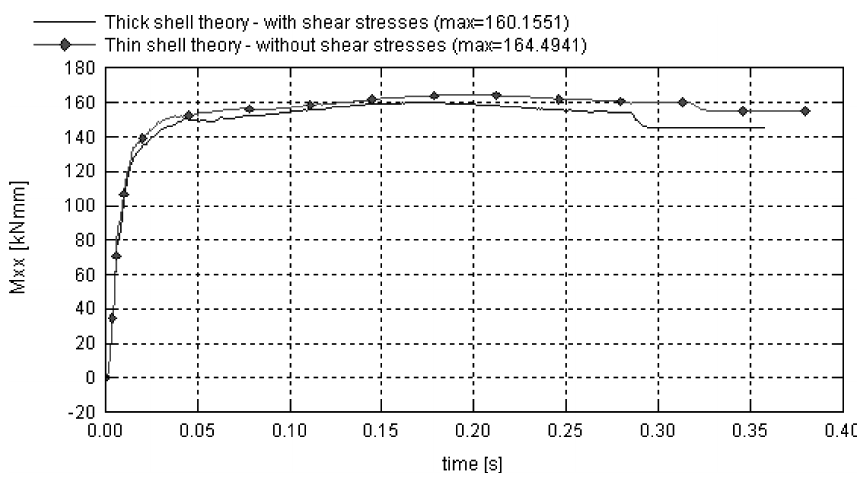
Fig. 16. Bending moment at midspan of the cylinder subjected to a ring of pressure ( t = 5 mm). rate-dependent behavior of thick plates and shells. A stress-resultant-based, dynamic yield surface is used, with shear forces calculated from transverse shear